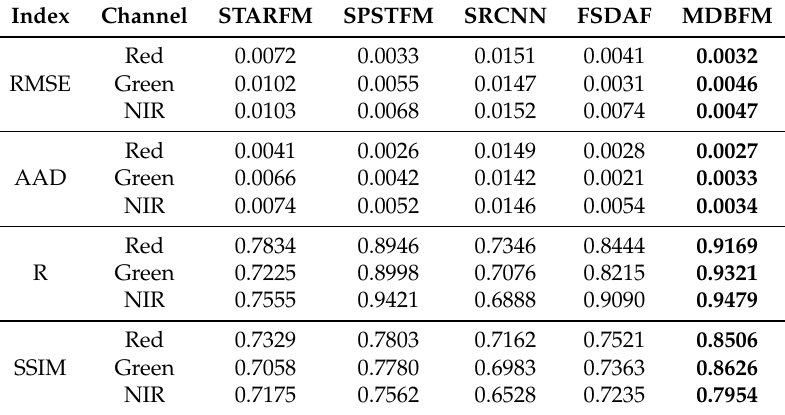
Table 3. Indexes analysis of data with type changes.